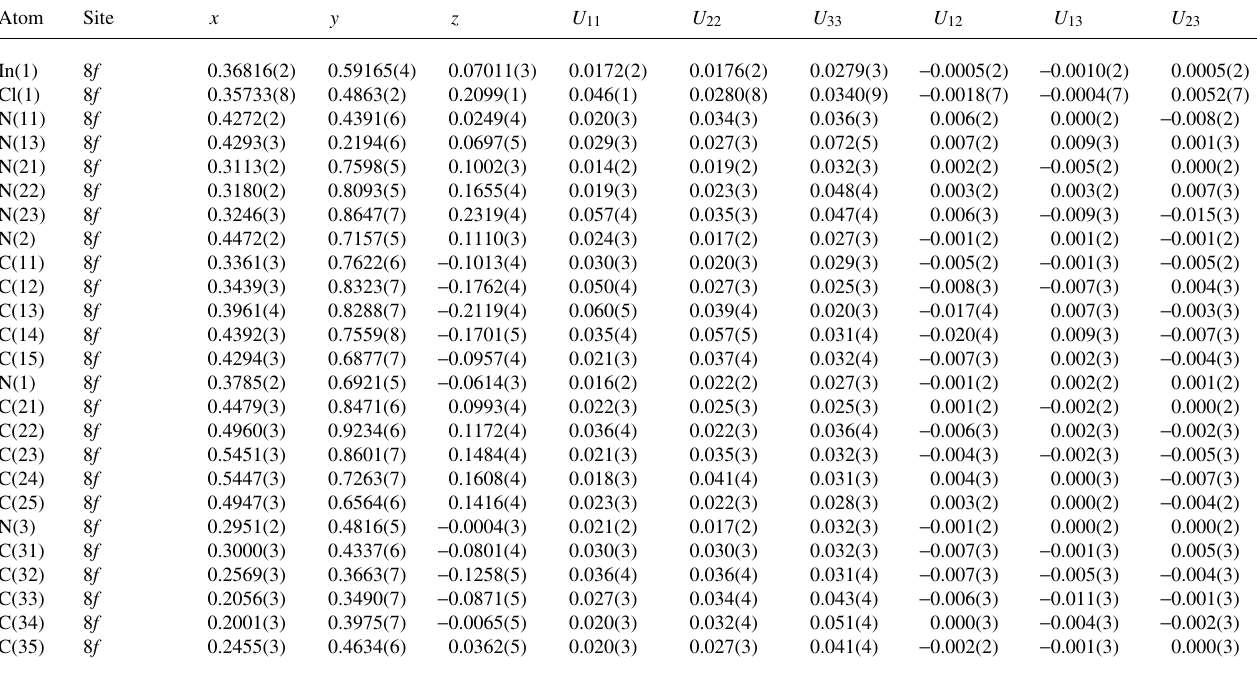
Table 3. Atomic coordinates and displacement parameters (in Å 2 )